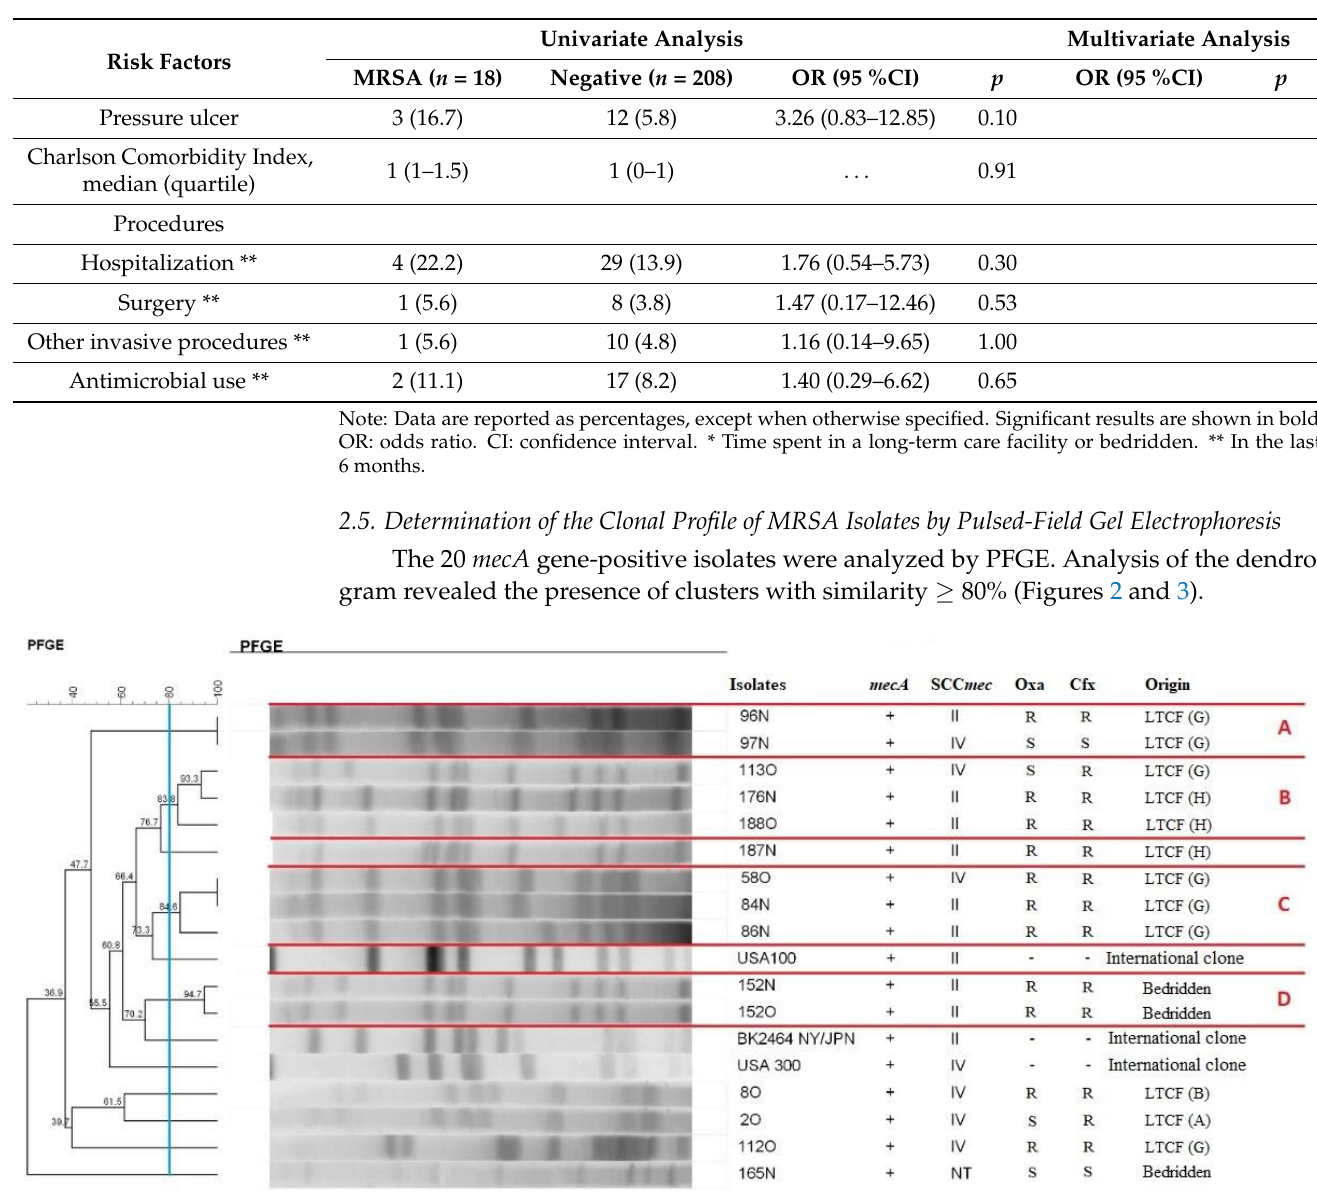
Figure 2. Dendrogram of PFGE- SmaI profiles of MRSA isolated from bedridden patients at home or